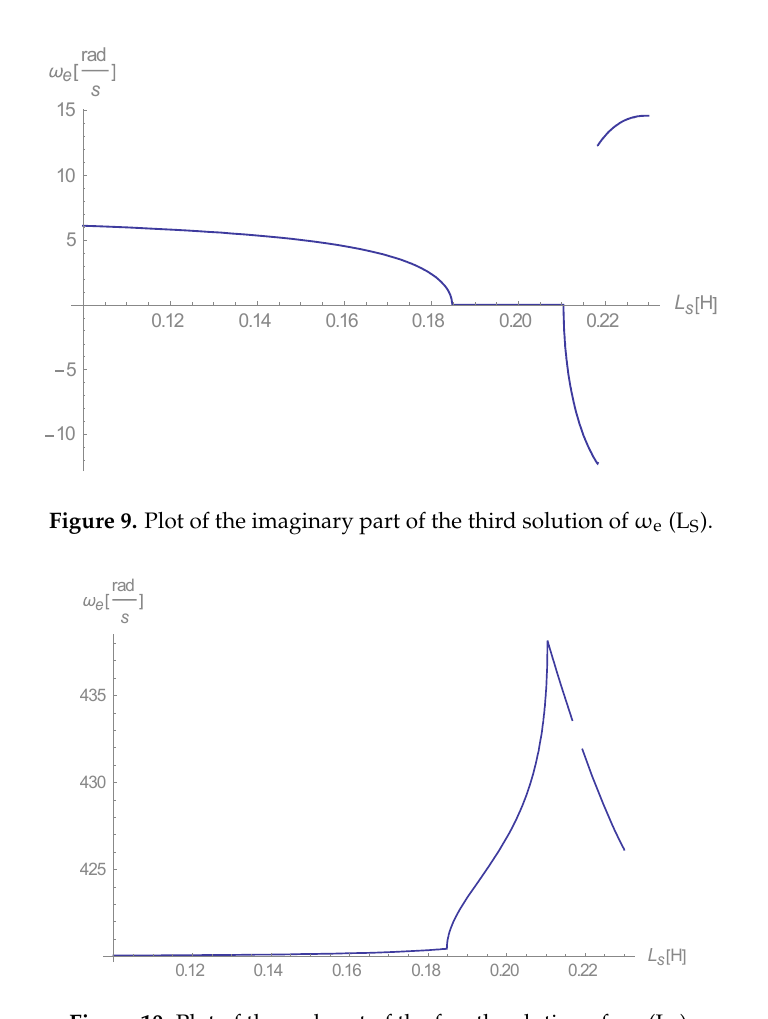
Figure 11. Plot of the real part of the fifth solution of ω (cid:2915) (L S ).